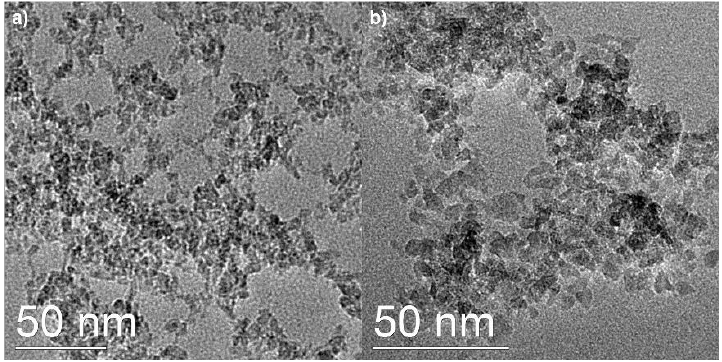
Figure 3. TEM images of ( a ) TiO 2 @SS_S_1:0.1 and ( b ) TiO 2 @SS_S_1:1 samples.